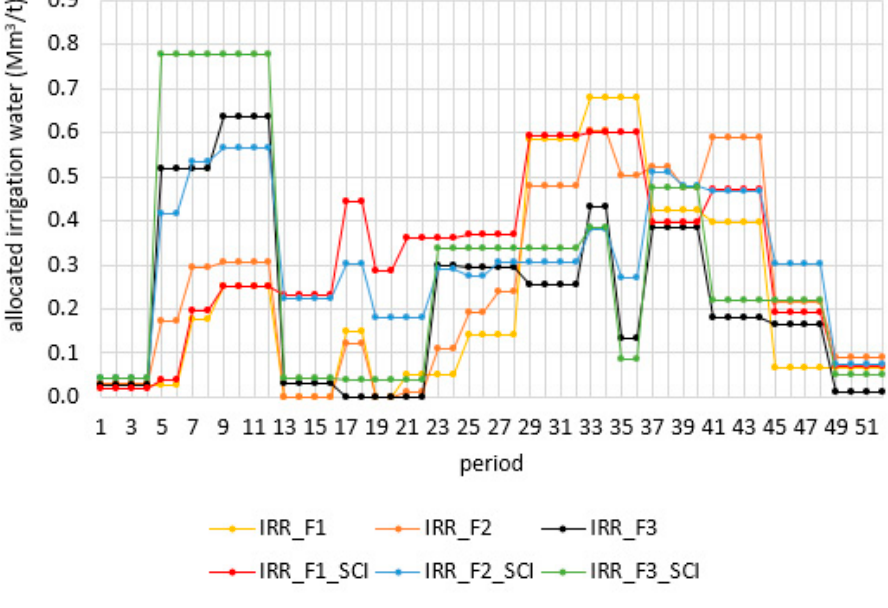
Figure 32. Comparison of irrigation water allocation between scenario I and base scenario model conditions(Mm 3 /week).